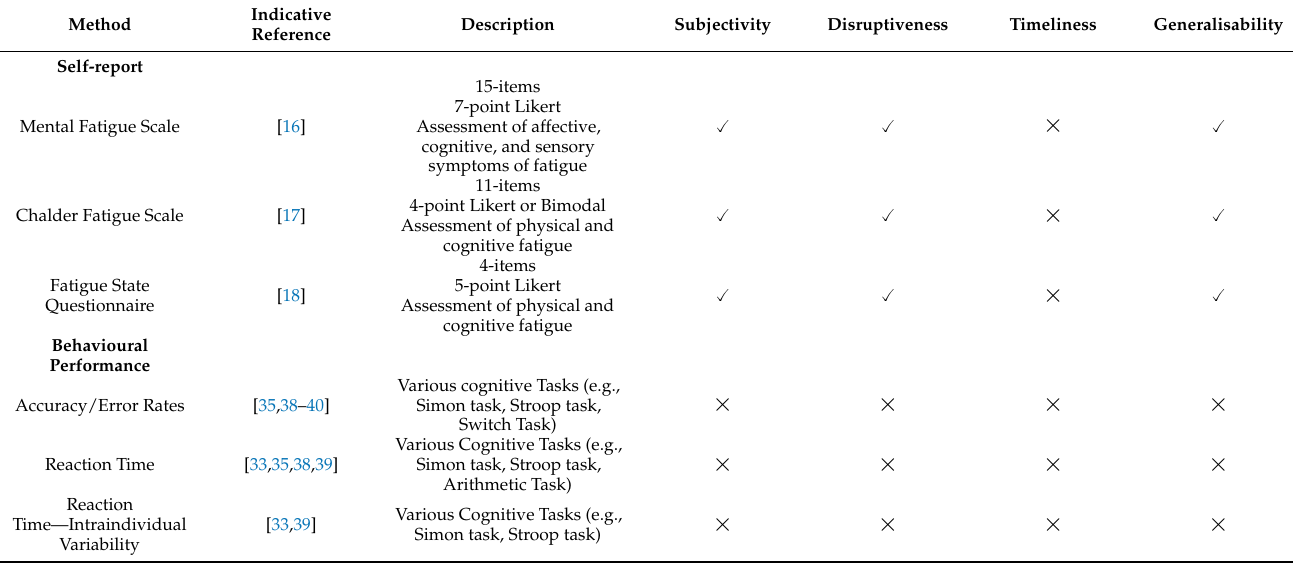
Table 1. Traditional cognitive fatigue assessment